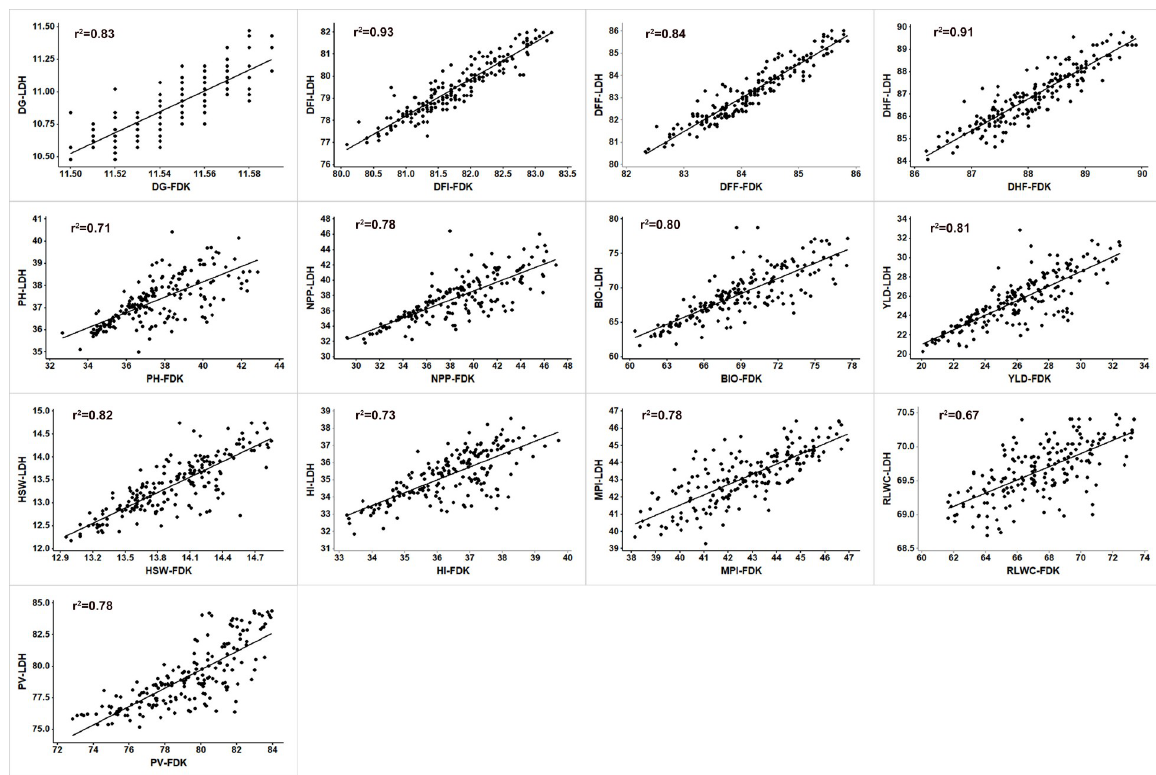
Fig 3. The scatter plots of heat stress related traits showing relationship between both locations, i.e., Ludhiana and Faridkot. The straight was plotted as regression line. DG = days to germination, DFI = days to flowering initiation, DFF = days to 50% flowering, DHF = days to 100% flowering, PH = plant height (cm), NPP = Number of pod per plant, BIO = biomass per plant (g), YLD = yield per plant (g), HSW = 100-seed weight (g), HI = harvest index (%), MPI = membrane permeability index, RLWC = relative leaf water content (%), PV = pollen viability (%), LDH = Ludhiana location, FDK = Faridkot